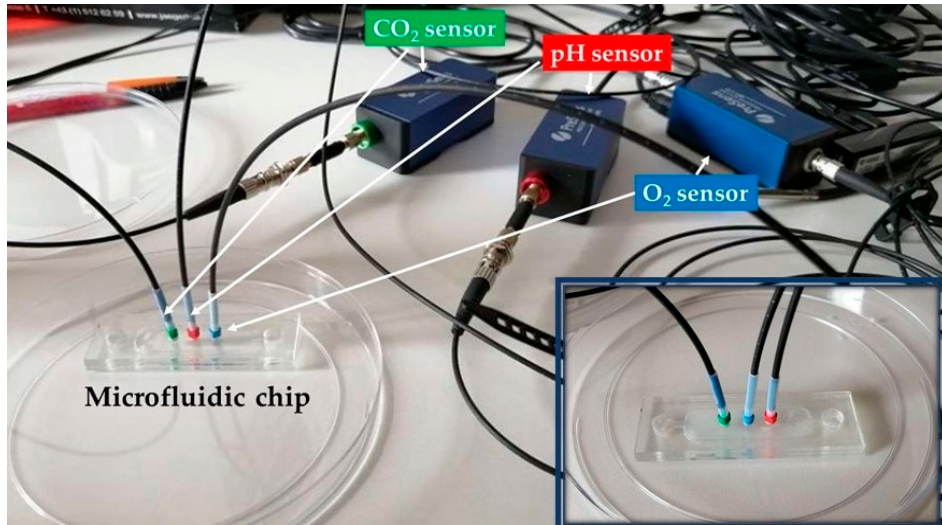
Figure 2. Experimental setup. Optical cables are connecting the PreSens sensors with SensorPlugs that are in direct contact with the sample in the MF chip. The PreSens sensors are connected to PC and software PreSens Measurement Studio 2 RC. Table 1. Calibration parameters for pH sensor.